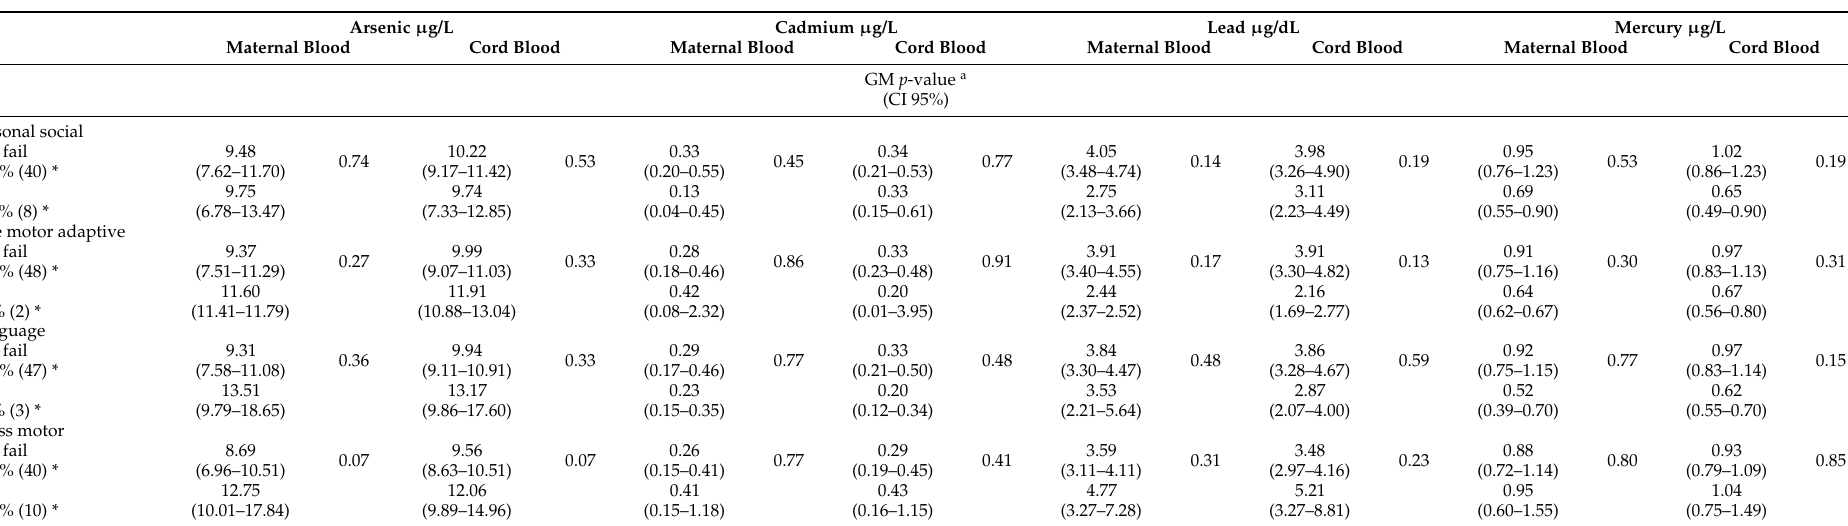
Table 6. Geometric means of metal concentrations in maternal blood and cord blood of the “not fail” and “fail” groups in the DDST-II tool for each assessed domain, Rio de Janeiro, Brazil,